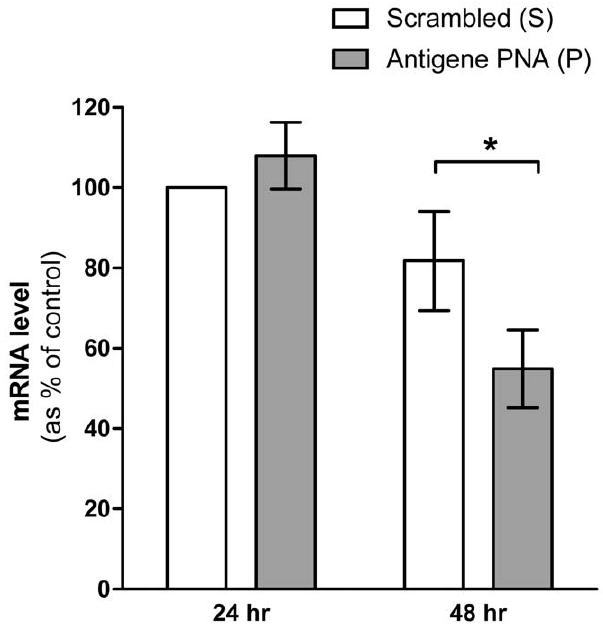
Figure 1. MDR 1 mRNA levels in KB-8-5 cells 24 hr and 48 hr post transduction with IVP-scrambled (S) or IVP-antigene PNA (P). MDR 1 mRNA levels were normalized by GAPDH levels, and are reported relative to the MDR 1 mRNA level of cells transduced with S , 24 hr post transduction. A significant difference (*, p , 0.05) was observed between P and S at 48 hr post transduction. Error bars represent the standard deviation from the average of three experi-